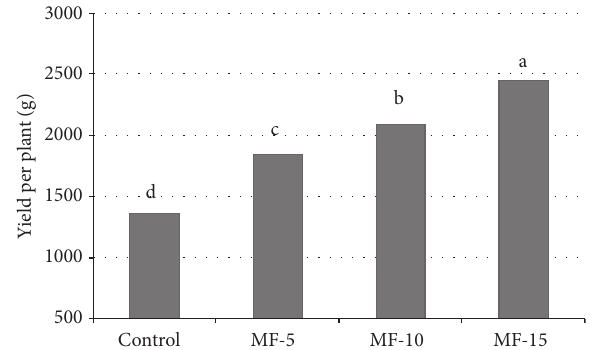
Figure 3: Pulsed electromagnetic field effect on yield per plant. Seeds have been exposed for 0, 5, 10, and 15 minutes in magnetic field. Means followed by the same letter for treatments are not significantly different according to the LSD 5% test. Control: untreated seeds; MF-5, MF-10, and MF-15: seeds treated with pulsed electromagnetic field for 5min, 10min, and 15min, respectively.